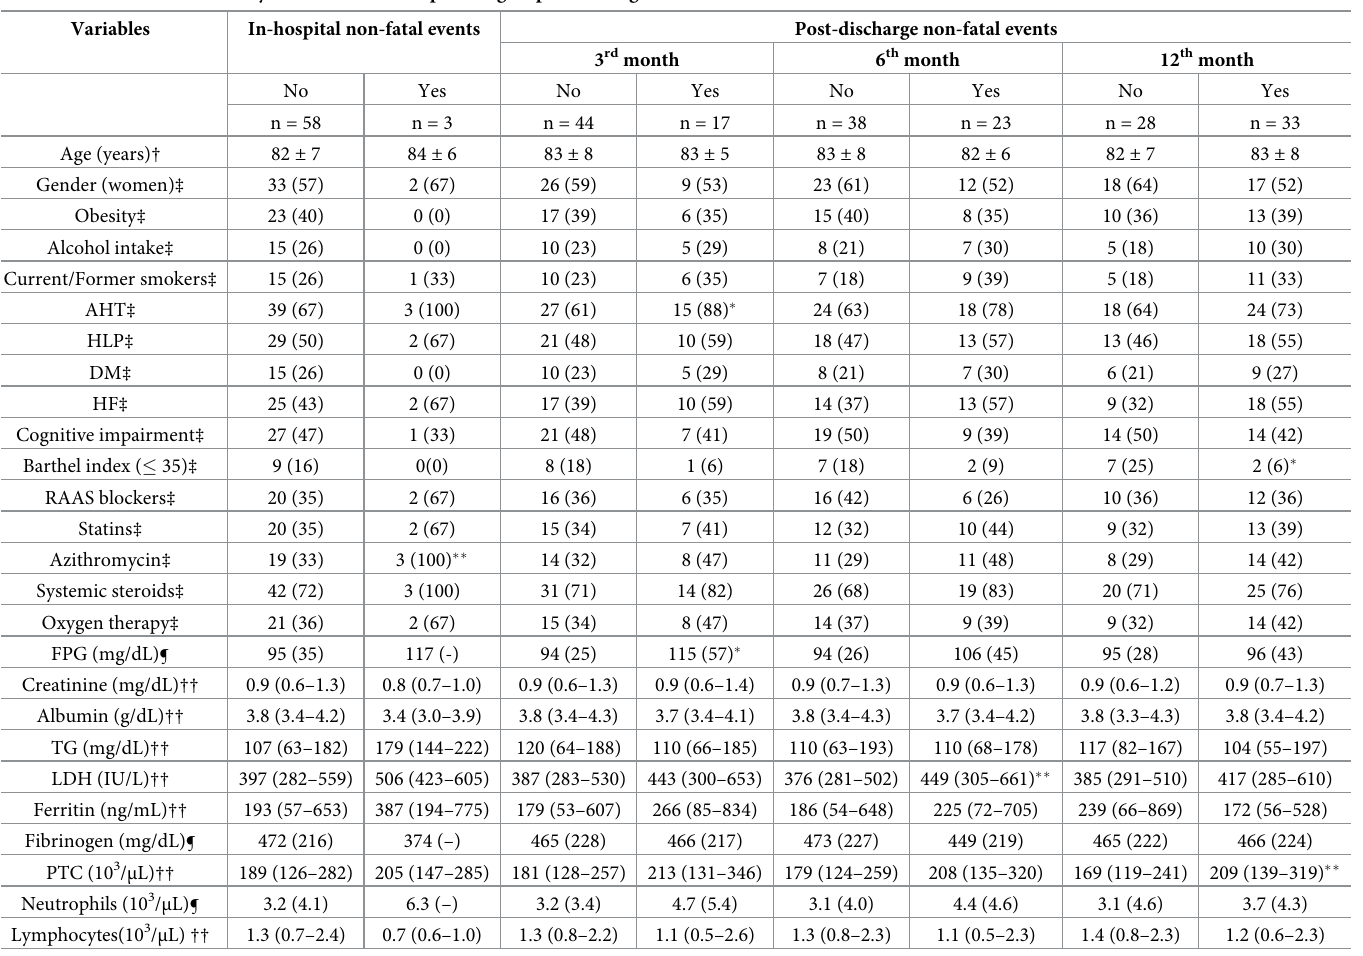
Table 2. Clinical and laboratory features of the comparison groups attending to non-fatal